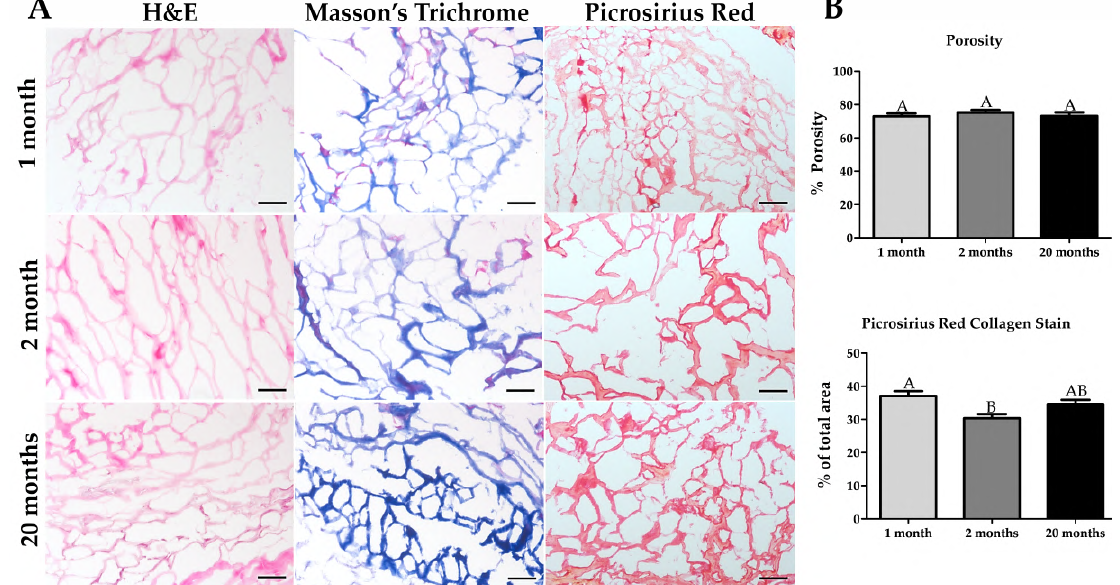
Figure 3. Decellularized muscle matrix (DMM) had no differences in collagen staining with old age. ( A ) Hematoxylin and Eosin (H&E) staining confirmed the absence of cell nuclei at all ages, indicating successful decellularization. Masson’s trichrome did not show age differences, while Picrosirius Red staining shows a thickening of the collagen with age in DMM. ( B ) There is no difference in porosity with age as measured with H&E staining. The amount of collagen area stained with Pricoririus Red staining is more significant in immature muscle compared to young adult. Although the mean area in old age is higher than in young adults, it is not statistically higher nor different from the immature muscle. Scale bar = 100 μ m. Groups that do not share a letter (e.g. A or B) are statistically different according to a one ‐ way ANOVA followed by a two ‐ tailed Tukey’s correction ( p < 0.05, n = 6).